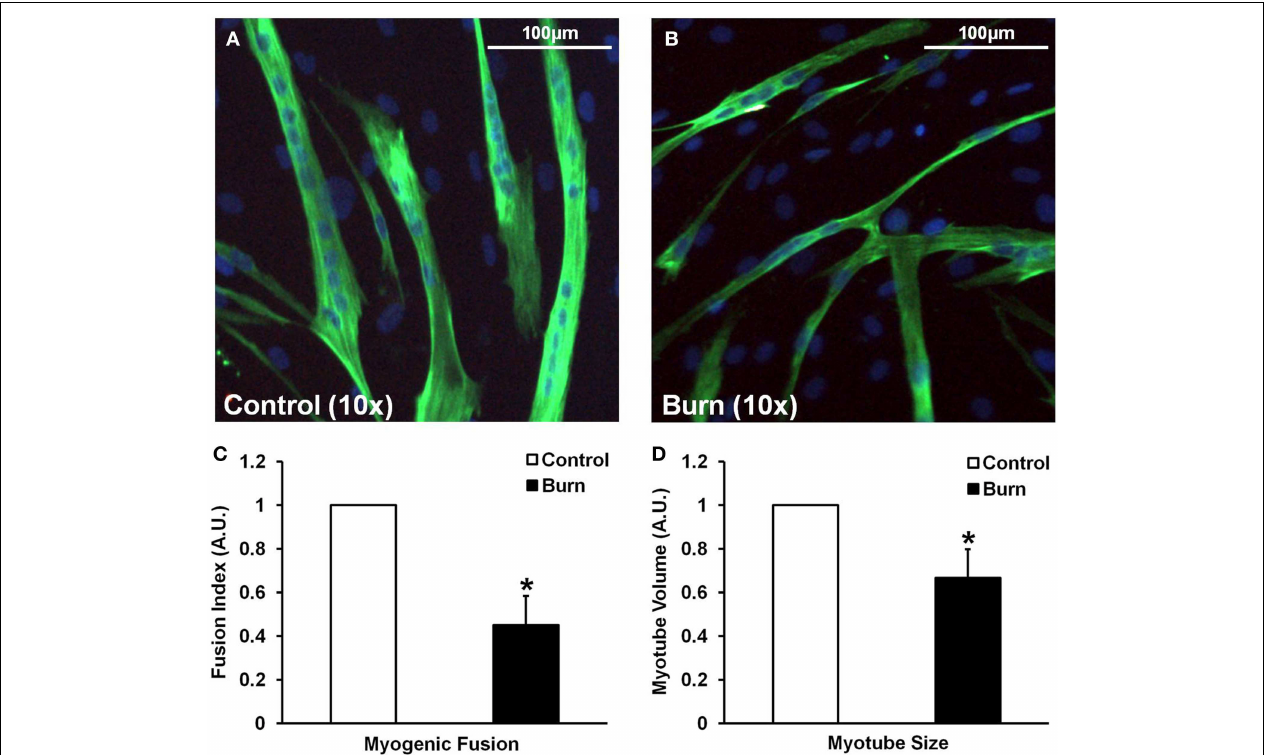
FIGURE 4 | Effects of burn serum on myogenic fusion (C) and myotube size (D). (A,B) are representative immunocytochemical images of myotubes differentiated in control (A) or burn (B) serum. ∗ Different from control at respective time point; P < 0 . 05